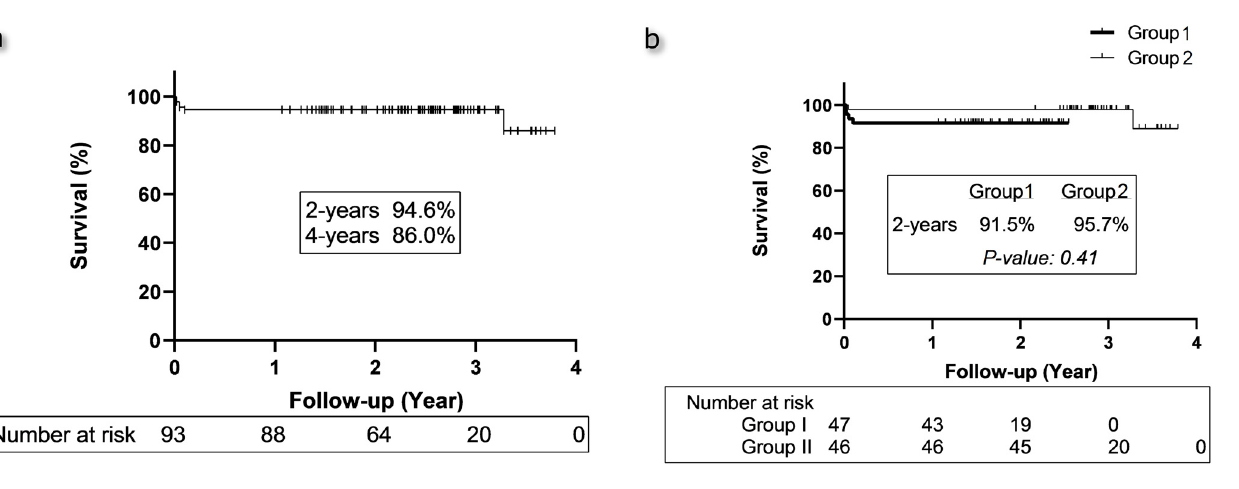
Fig. 4A – Survival curve for all patients. Fig. 4B – Survival curves according to the